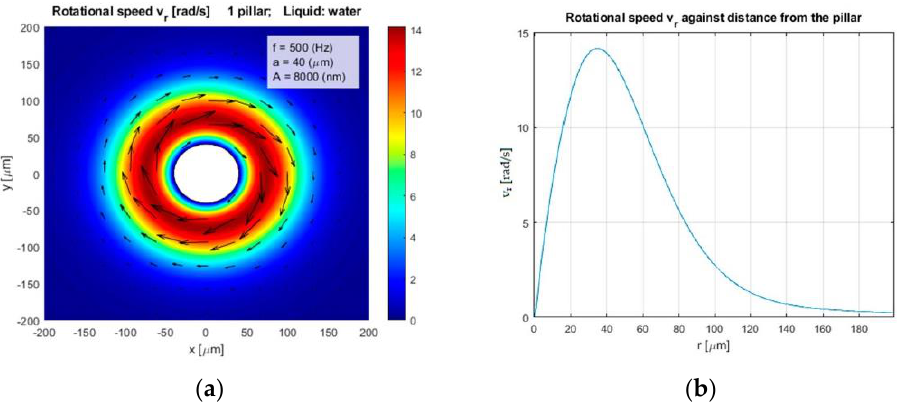
Figure 3. ( a ) Rotational velocity of water stream 𝑣 𝑟 and, ( b ) its amplitude as a function of distance from the pillar.